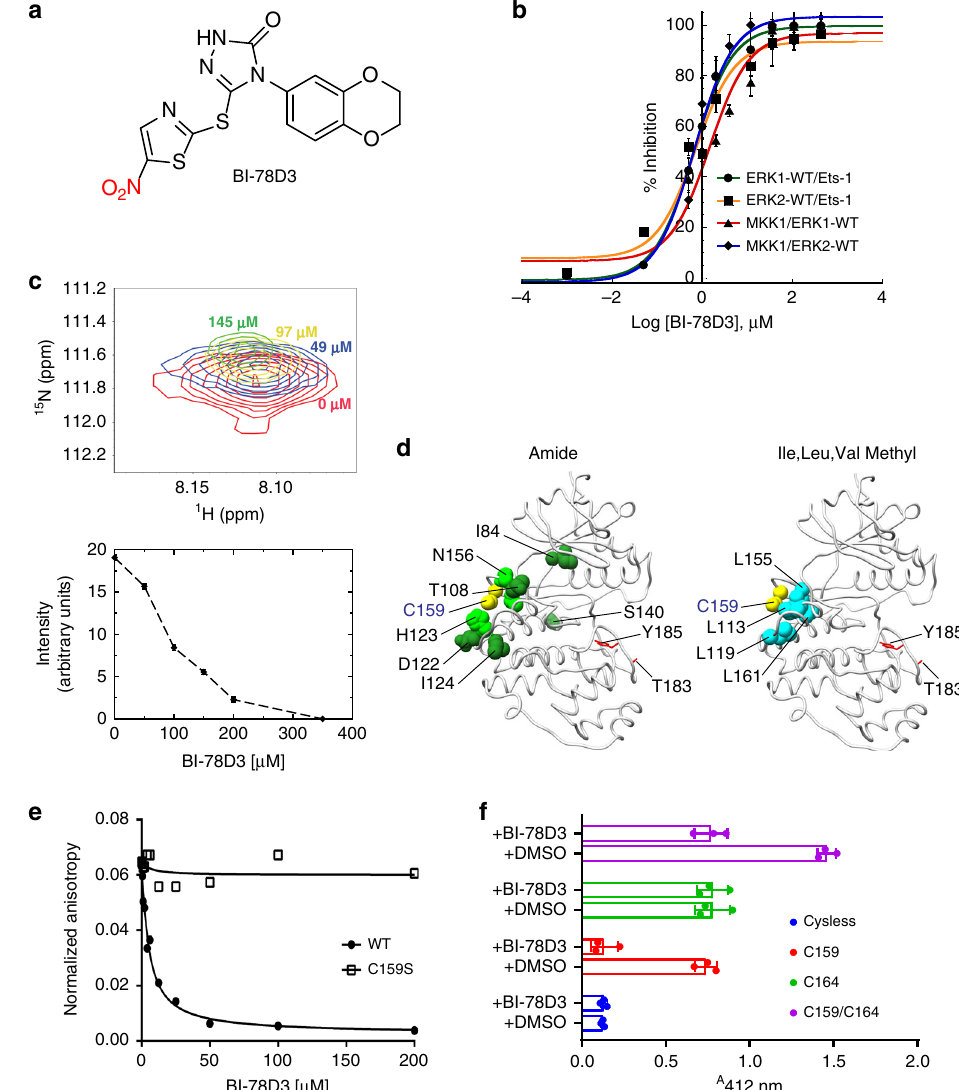
Fig. 1 BI-78D3 labels C159 of ERK2 . a Chemical structure of BI-78D3. b BI-78D3 inhibits ERK1/2 phosphorylation by constitutively active MKK1 (MKK1G7B) and inhibits the phosphorylation of Ets-1 by activated ERK1/2. Different concentrations of BI-78D3 were incubated with either unphosphorylated or activated ERK1/2 for 30 min before the addition of [ γ - 32 P] ATP and MKK1G7B or Ets-1, respectively (data are from three independent experiments for Ets-1 assays and two for MKK1G7B assays, and bars represent mean ± SD (standard deviation)). c The top panel shows an expansion of the region corresponding to C159 in 15 N, 1 H TROSY (600 MHz) spectra of inactive ERK2 (200 μ M) in the presence of increasing amounts of BI-78D3. The bottom panel shows the change in the relative intensity of the C159 resonance in these spectra with increasing concentrations of BI-78D3. d Residues that show signi fi cant spectral perturbations calculated from 15 N, 1 H TROSY (800 MHz) or 13 C, 1 H HMQC (800 MHz) spectra of ERK2 in the presence of approximately equimolar amounts of BI-78D3 for backbone amide (left panel) or Ile ( δ 1), Val and Leu methyls (right panel) resonances are indicated on the structure of ERK2. Residues for which the amide or methyl chemical shift perturbations exceed the corresponding average plus twice the standard deviation are colored dark green and cyan, respectively. Residues for which amide resonances that are broadened to below the noise are colored light green. C159 is shown in yellow (and labeled in blue) and the activation loop T183 and Y185 are shown in red stick representation. All of the spectral perturbations in both cases are centered in and around the DRS of ERK2. e Fluorescence anisotropy was employed to assess the ability of BI-78D3 to competitively displace a fl uorescent D-site-containing peptide from the DRS of activated ERK2 and ERK2 C159S (represents one experiment out of two repetitions). f Speci fi city of BI-78D3 towards C159 and C164. ERK proteins (5 µ M) were incubated with 100 µ M BI-78D3 for 60 min. Free thiol was titrated using Ellman ’ s reagent (data are from three independent experiments, and bars represent mean ±